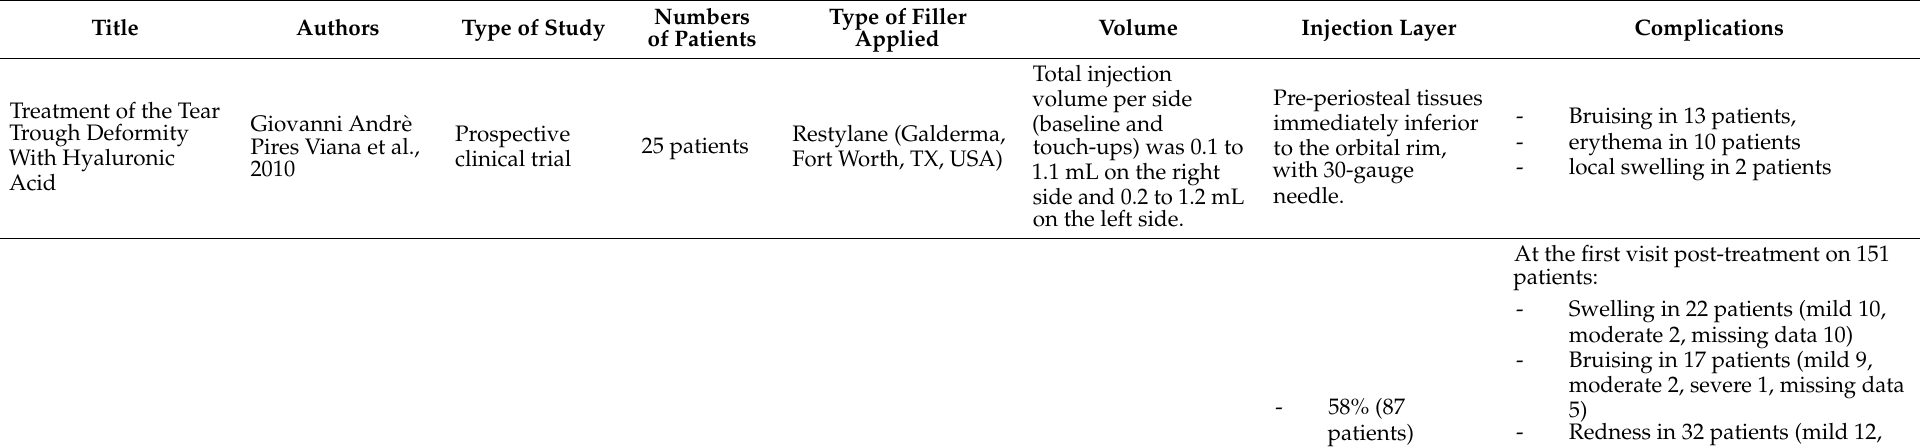
Table 1. Results of individual